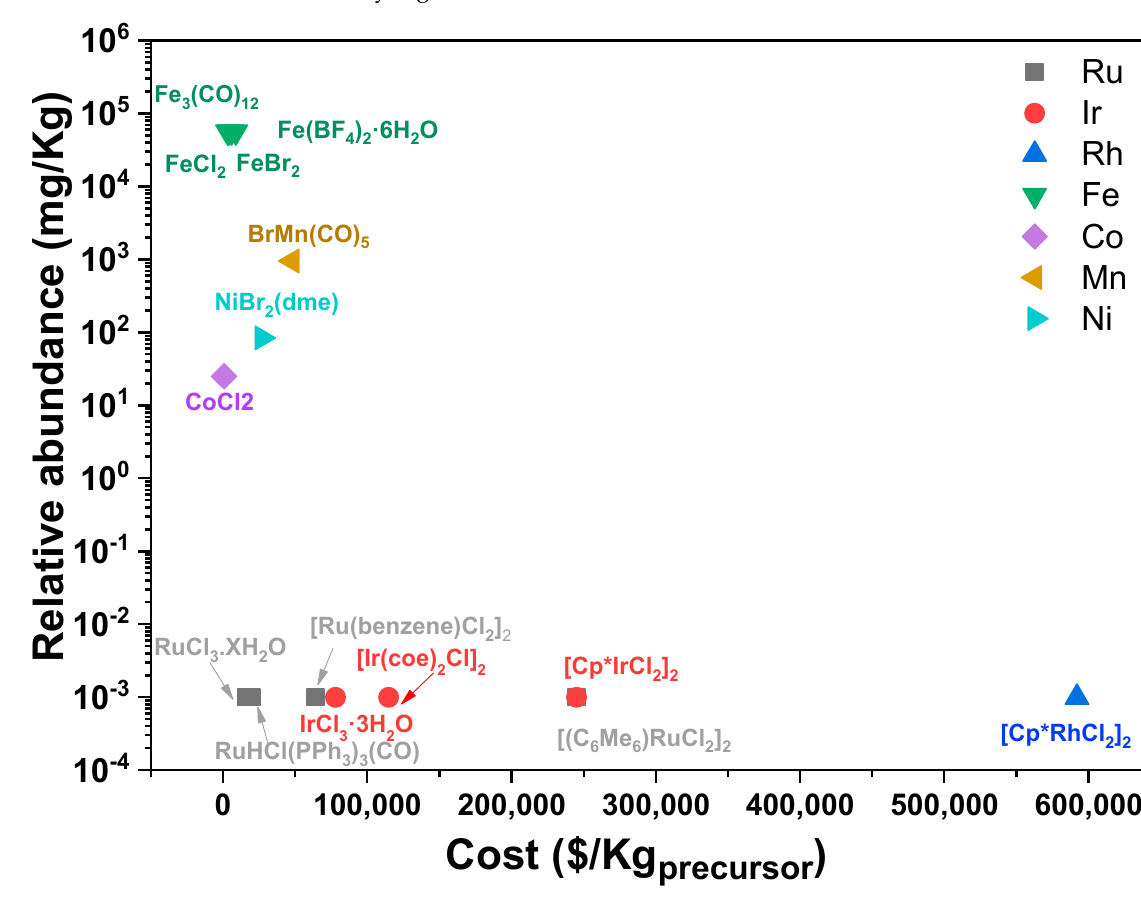
Figure 9. Correlation plot of relative abundance (mg/kg) versus cost ($/kg) of various metal precursors. Table 1. Cost analysis based on the metal